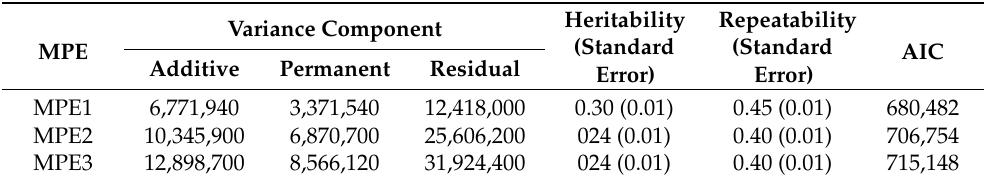
Table 3. Estimated genetic variance of methane and Akaike’s information criterion (AIC) for each methane prediction equation